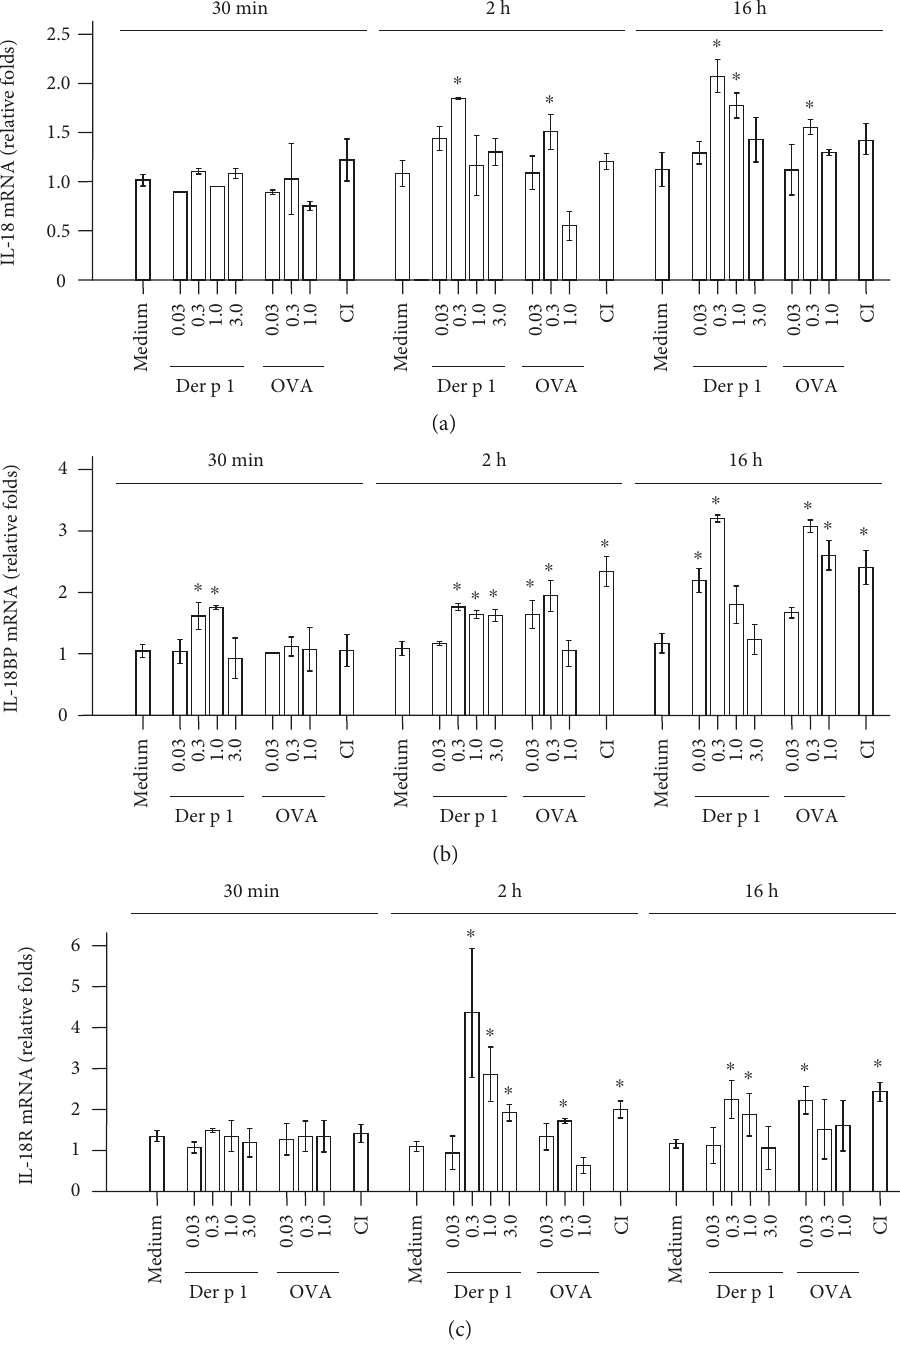
Figure 6: Quantitative real-time PCR (qPCR) analysis of the expression of IL-18, IL-18BP, and IL-18 receptor (IL-18R) mRNA in HMC-1 mast cells. Cells were challenged by various concentrations of group 1 house dust mite allergen Der P 1, ovalbumin (OVA), or calcium ionophore (CI) at 37 ° C for 2 h and 16h. The expression of IL-18 (a), IL-18BP (b), and IL-18R (c) mRNAs were analyzed by qPCR. The data were expressed as mean ± SE for four separate experiments performed in duplicate. ∗ P < 0 05 compared with the response to corresponding medium alone control. P < 0 05 in comparison of the reduced response with the response to the corresponding allergen alone. P < 0 05 in comparison of the enhanced response with the response to the corresponding allergen